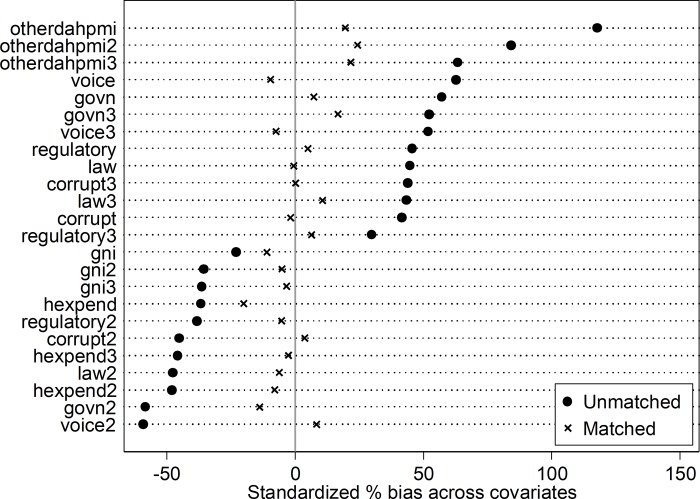
Covariate balance between PMI- and non-PMI-recipient countries: Standardized percentage bias across covariates.Abbreviation: hexpend = Domestic health expenditure, gni = gross national income, otherdahpmi = Other development health assistant minus PMI, govn: Effective governance, voice: Voice and accountability, regulatory: Regulatory quality; index number 2 and 3 represent 2nd and 3rd order polynomial terms, respectively.